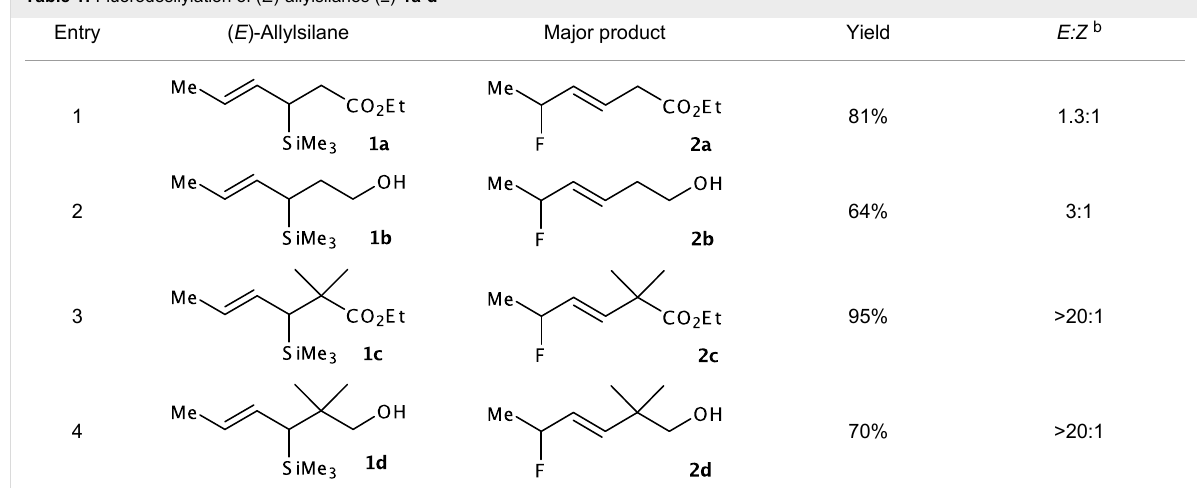
Table 1: Fluorodesilylation of ( E )-allylsilanes (±)- 1a-d a Entry ( E